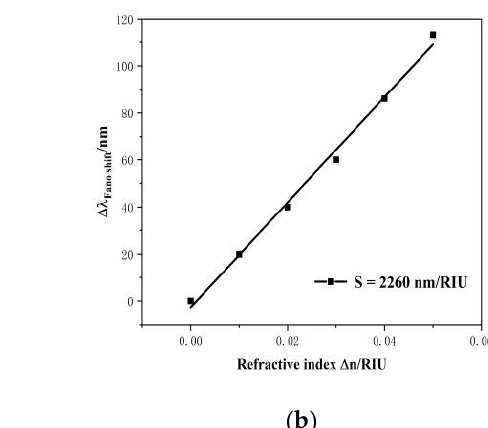
Figure 4. ( a ) Transmission spectrum of the whole system for various refractive indexes; ( b ) variation of the dip point’s wavelength in Fano resonance ( Δλ ) with a changed refractive-index ( Δn ).